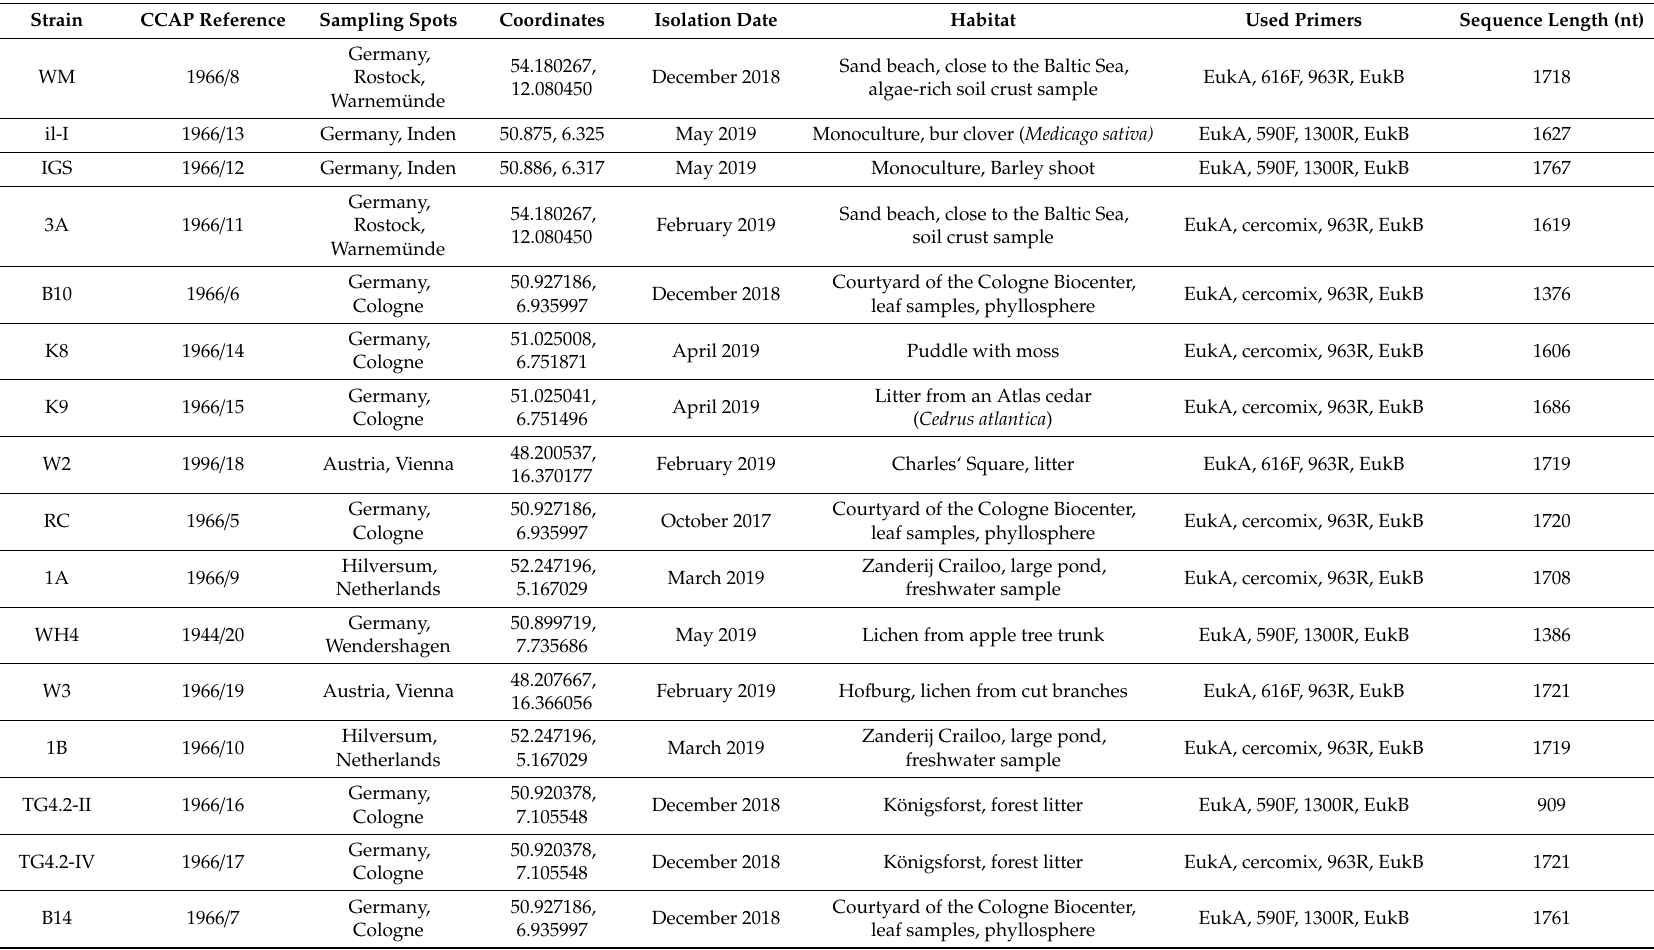
Table 1. Corresponding data of obtained Rhogostoma spp.